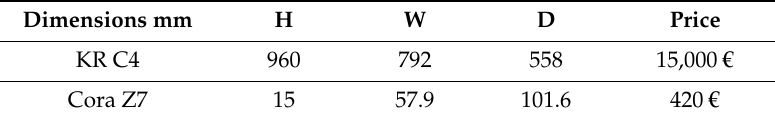
Table 1. Comparison between our approach and an industrial arm